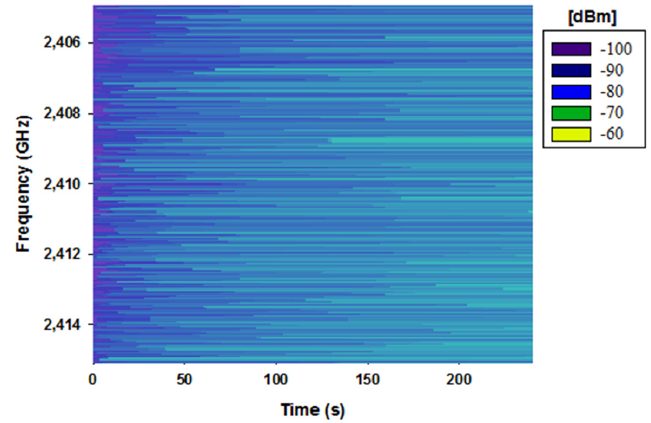
Figure 5. Measured spectrogram within the scenario under analysis for the ZigBee channel 12.